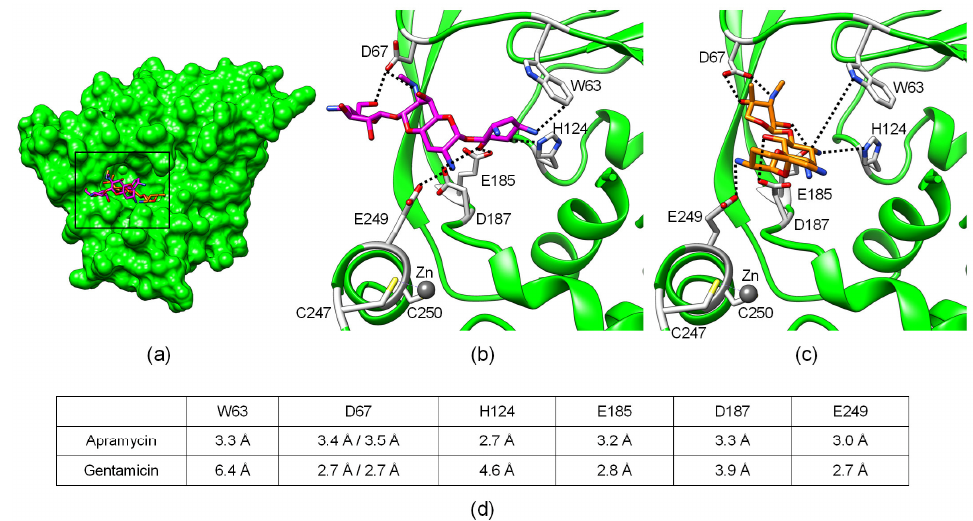
Figure 2. Crystal structure of AAC(3)-IV in complex with apramycin (PDB ID: 6MN4) or gentamicin (PDB ID: 6MN3). ( a ) Structural overview of full protein showing superimposition of bound substrates apramycin (magenta) and gentamicin (orange). Detailed view of ( b ) apramycin and ( c ) gentamicin in the binding pocket. Amino acids modified in this study are highlighted in gray. Residues D67, D187, and E249 are differently rotated in the apramycin versus the gentamicin structure. ( d ) Shortest intermolecular distances between amino acid side chains and ligand, corresponding to dashed lines in ( b , c ).